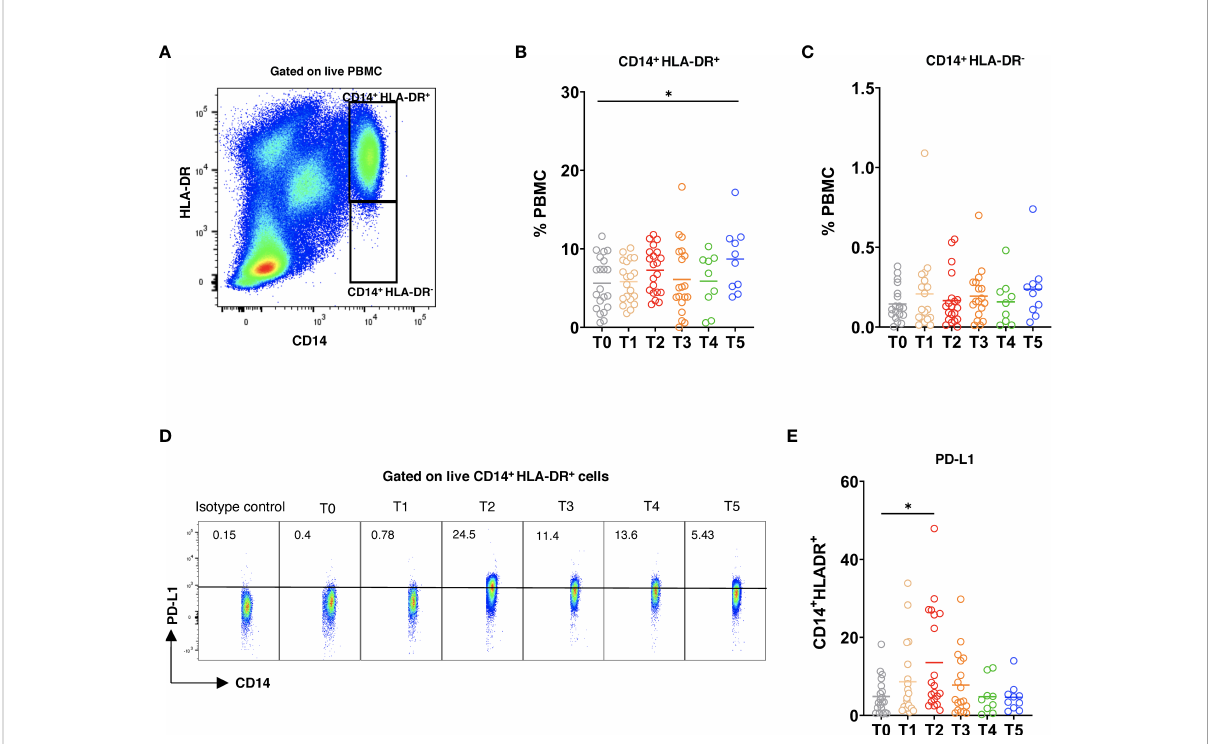
FIGURE 6 Myeloid cell phenotype after vaccination. PBMC were stained with 7AAD, CD14, HLA-DR, and PD-L1 mAbs and measured by fl ow cytometry. (A) Representative dot plots for CD14 + HLA-DR + and CD14 + HLA-DR - 7AAD - live myeloid cells. CD14 + HLA-DR + (B) and CD14 + HLA-DR - (C) cells were analyzed at different time points and are shown as the frequency of respective subset among total PBMC (n=21). (D) Representative dot plots for PD-L1 expression on CD14 + HLA-DR + cells. (E) Data are presented as the percentage of PD-L1 + CD14 + HLA-DR + cells among total CD14 + HLA-DR + cells. * P <